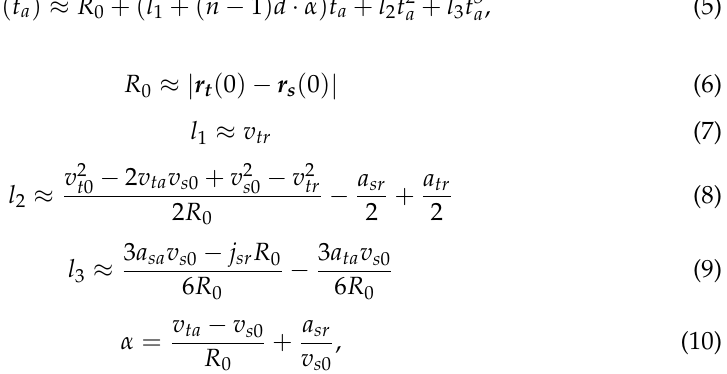
Figure 2. MEO multichannel SAR geometry. To facilitate the design of the GMTI method, the target’s range history is generally approximated by a Taylor series expansion around the time that the beam centerline crosses the target (i.e., t a = 0). In the case of MEO SAR, because of the obvious curve of the trajectory, a third-order Taylor series expansion should be adopted. By exploiting the vector projection and matrix differential, the cubic-approximated range equation for the multichannel system is given by [20] with